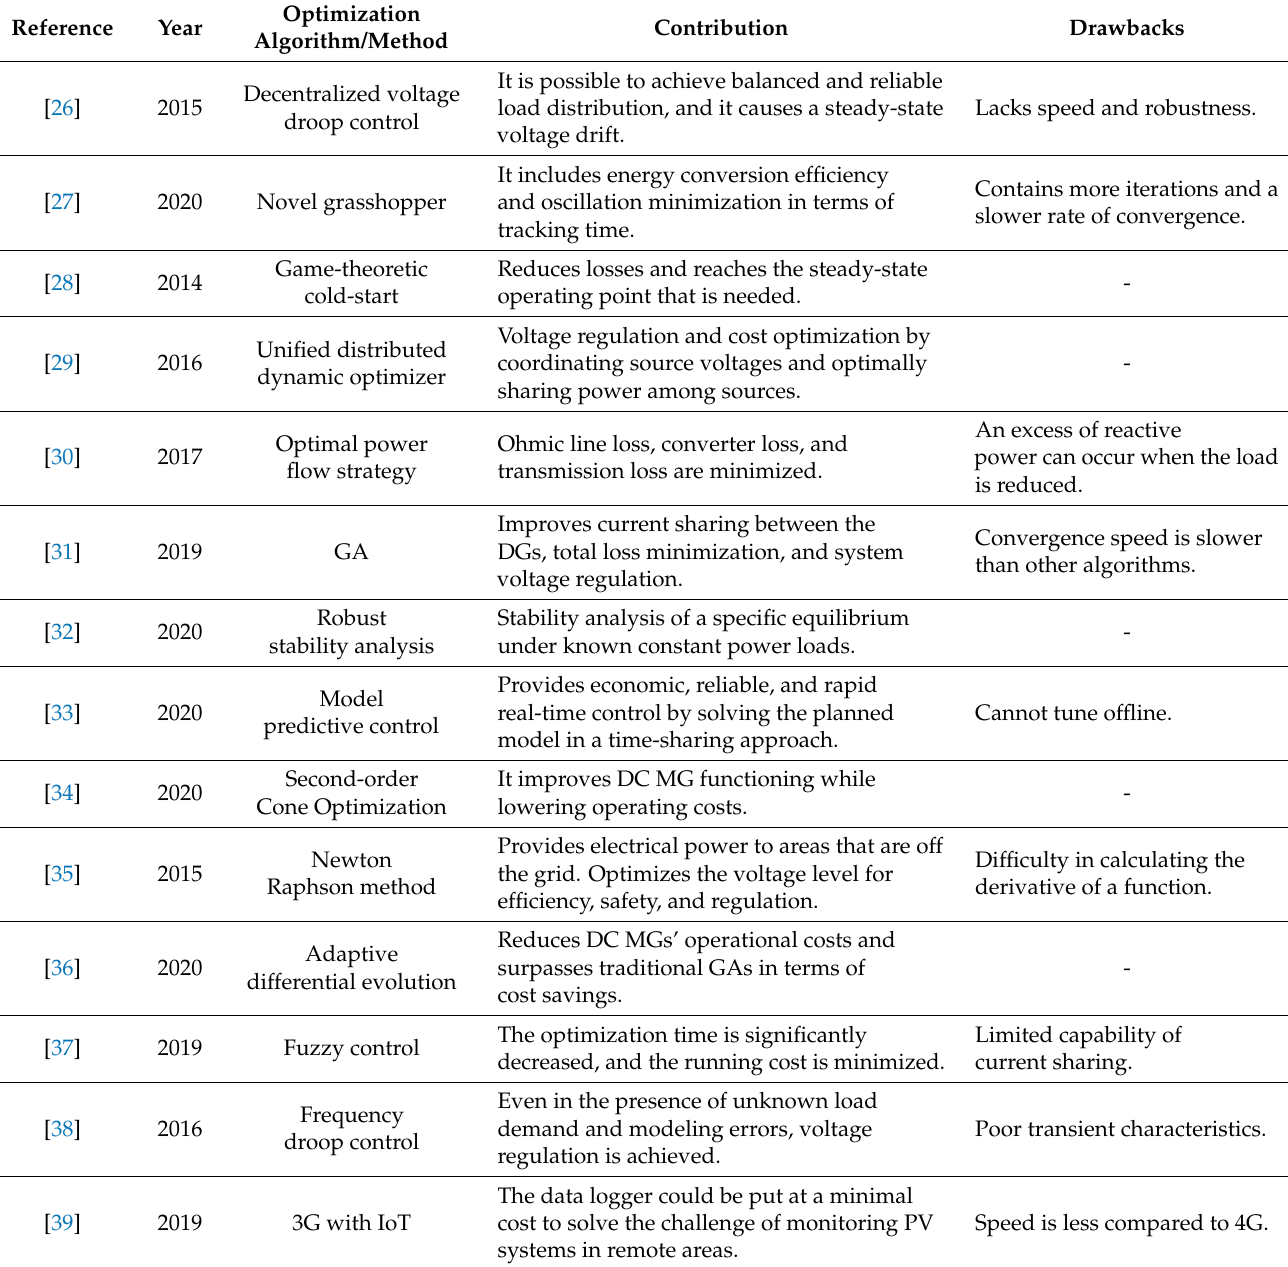
Table 3. Optimization methods for DC